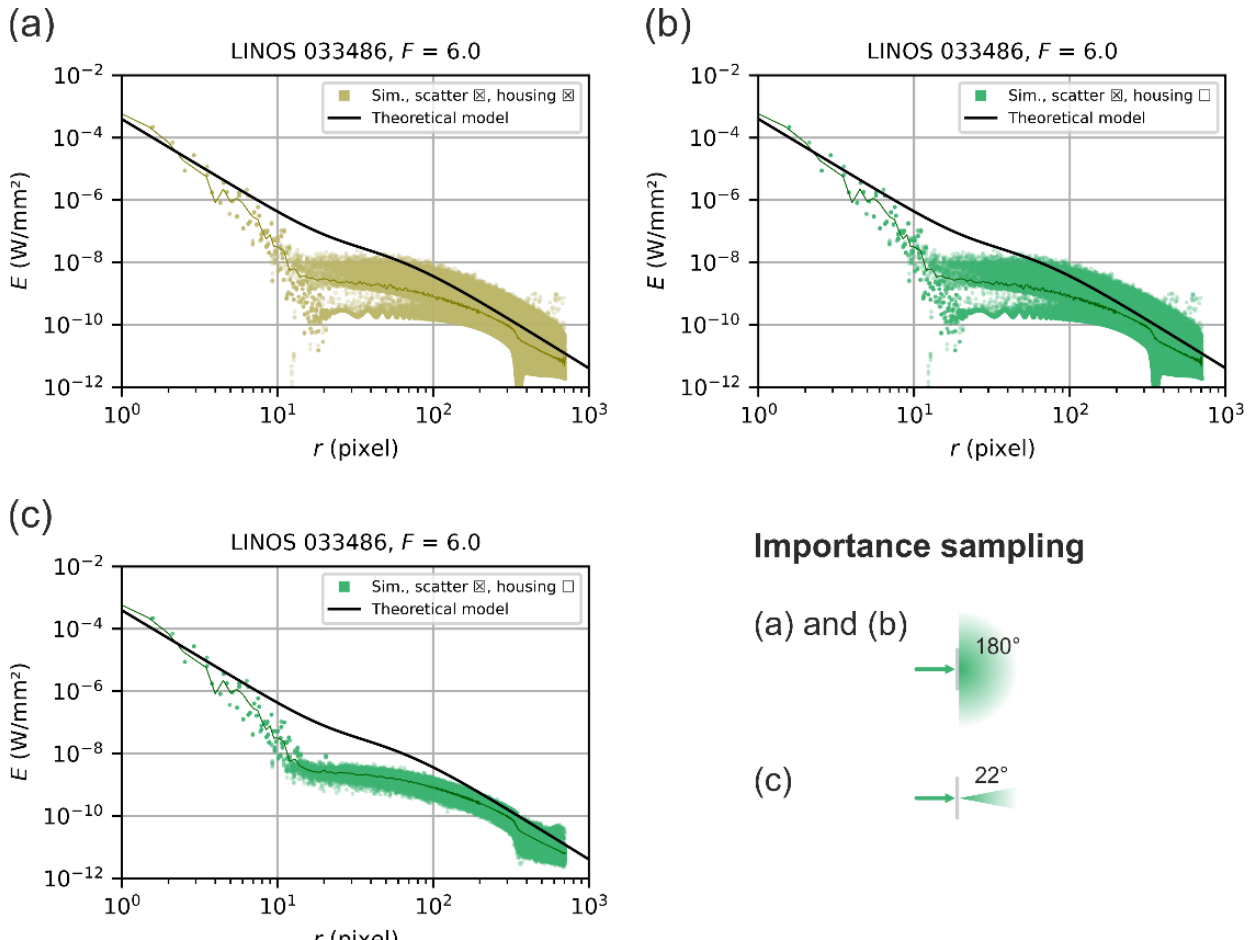
Figure A2. Simulation result for the LINOS 033486 lens at an f-number of 𝐹 = 6 . ( a ) Simulation considering housing and using adapted simulation settings. ( b ) Simulation without housing and using adapted simulation settings. ( c ) Simulation without housing using set 1 of simulation settings. The inset on the bottom right shows which importance sampling setting was used for each simulation. As a side note, we can observe that the distribution of the data points of Figure A1a and A1b using the adapted settings differs noticeably from the distribution of Figure A1c, which is the result using the set 1 of simulation settings.